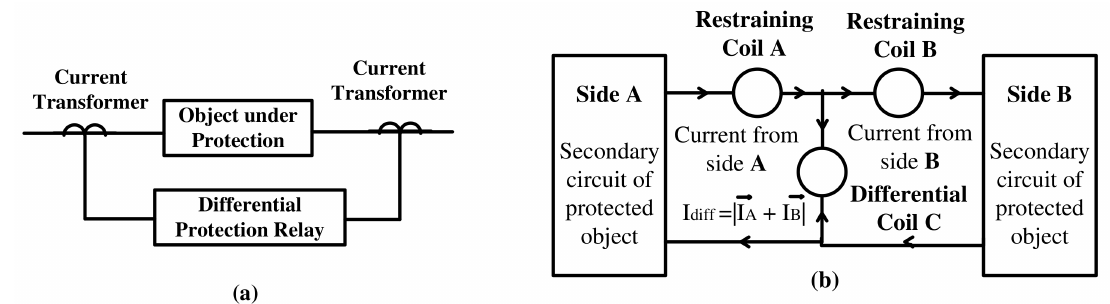
Figure 2. Differential protection relay: ( a ) single line diagram with connections [10] and ( b ) basic operating principle